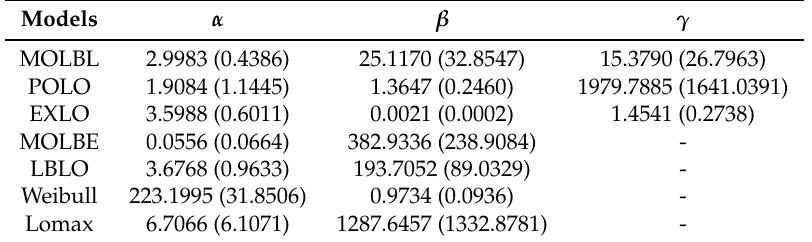
Table 7. Estimates and standard errors (in parentheses) of the parameters for Data set 1.